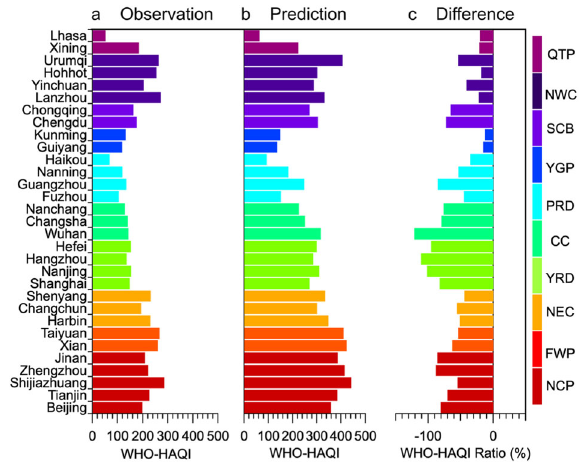
Fig. 4 WHO-HAQI derived from observations and the counter- factual prediction. a – c represent the observed and predicted WHO- HAQIs, and the relative difference between them for 31 capital cities in each province across China. Different colors represent different regions in China, containing clusters of the 31 capital cities in each province according to their geographic